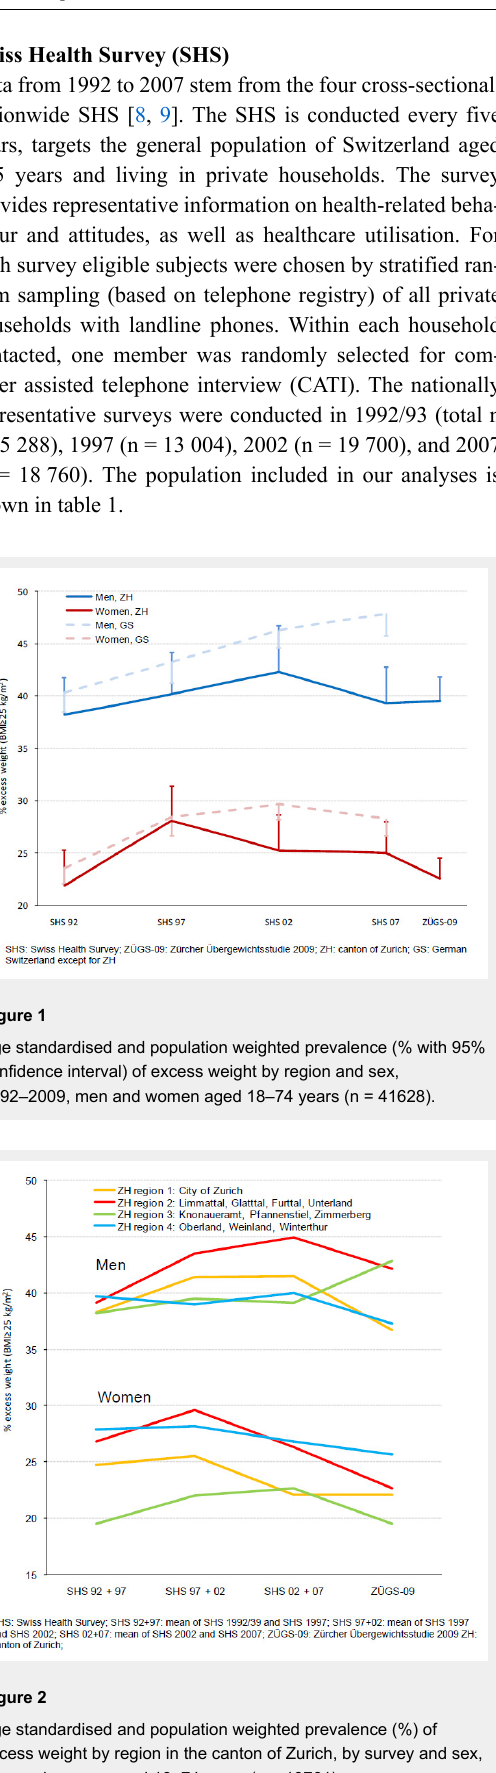
Age standardised and population weighted prevalence (%) of excess weight by region in the canton of Zurich, by survey and sex, men and women aged 18–74 years (n =